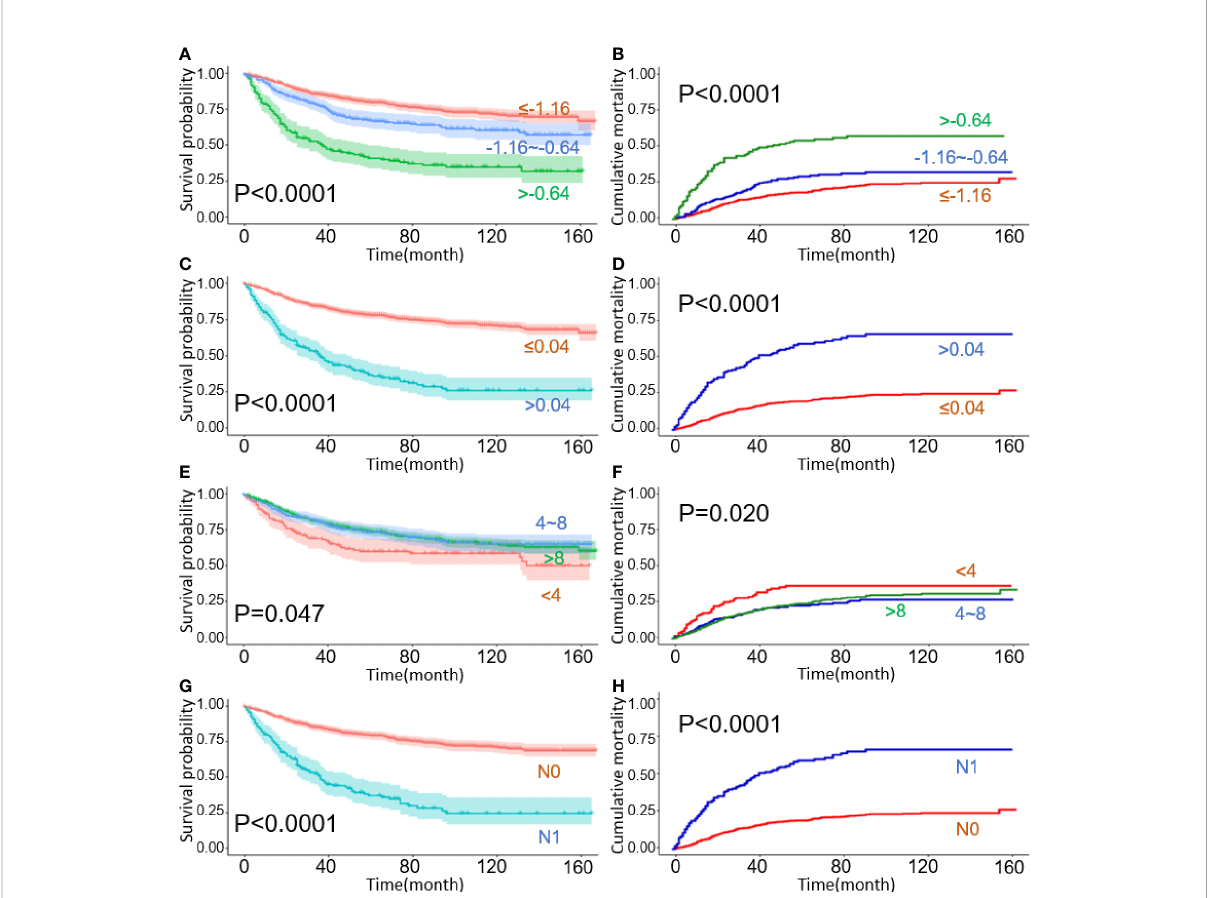
FIGURE 1 Kaplan – Meier curves for overall survival with cumulative incidence curves for cancer-speci fi c deaths, strati fi ed by lymph node staging schemes: (A, B) LODDS; (C, D) LNR; (E, F) TNLE; (G, H) N